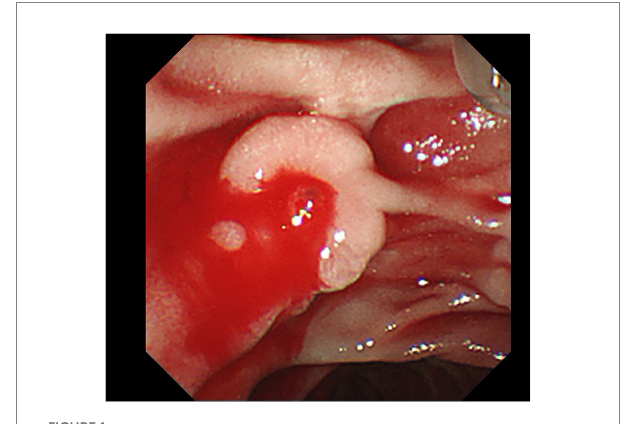
FIGURE 1 Pulsatile bleeding of the duodenal papilla after the clots were removed.